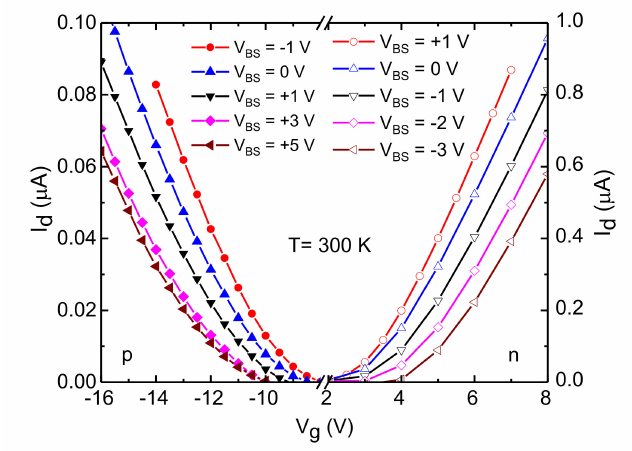
Figure 4. Transfer characteristics at room temperature (300 K) for different body biases (V BS ) for n- and p-channel MOSFETs. I d –V g sweeps were taken at a constant drain-to-source voltage (0.75 V). A change in V th can be observed due to the modulation of the depletion layer width at the body to source junction with the application of body bias. Note that the y-axis scales are different for the two kinds of